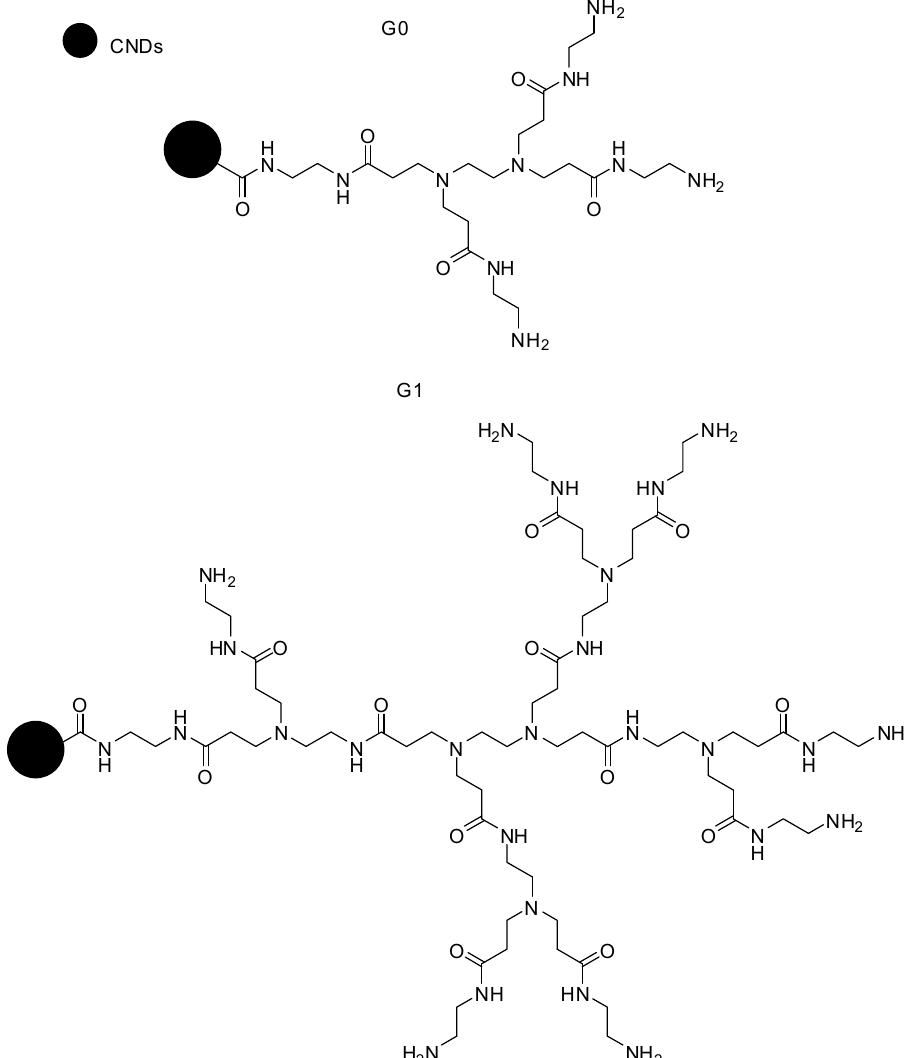
Figure 14. PAMAM dendrimer conjugated to CNDs (carbon nanodots) [119].